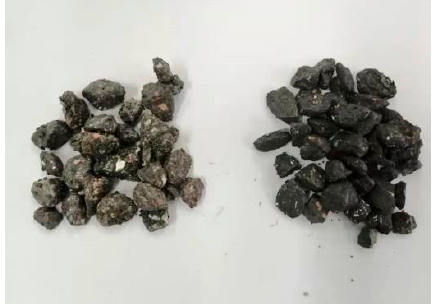
Figure 1. New iron-carbon-loaded substrate.